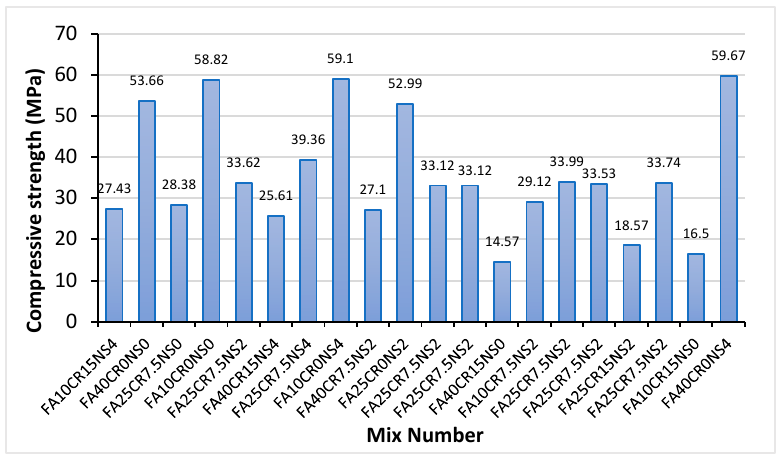
Figure 6. Compressive strength of RSCC mixes at 28 days.